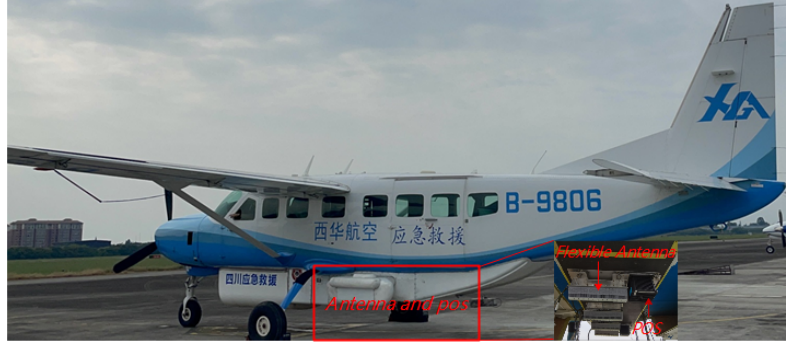
Figure 5. Schematic diagram of the system.